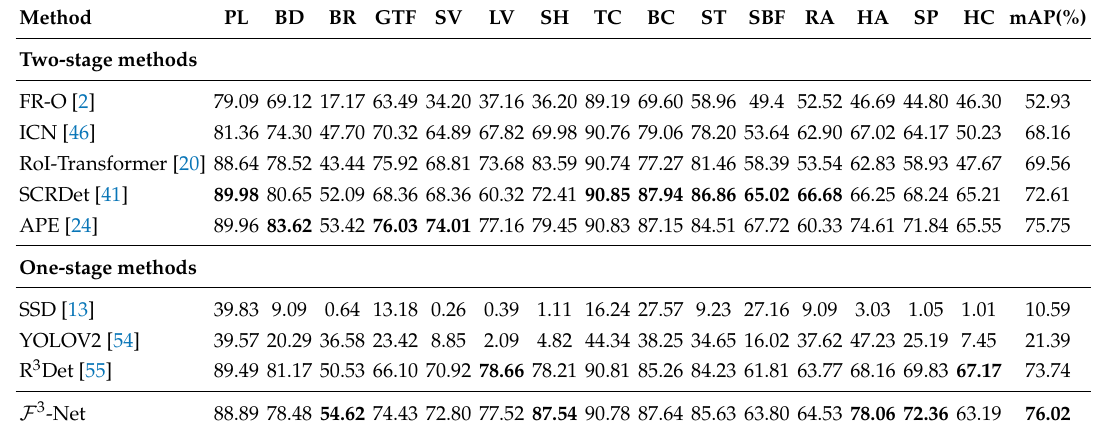
Table 2. Experimental comparison of the baselines and our F 3 − Net for OBB task on DOTA test